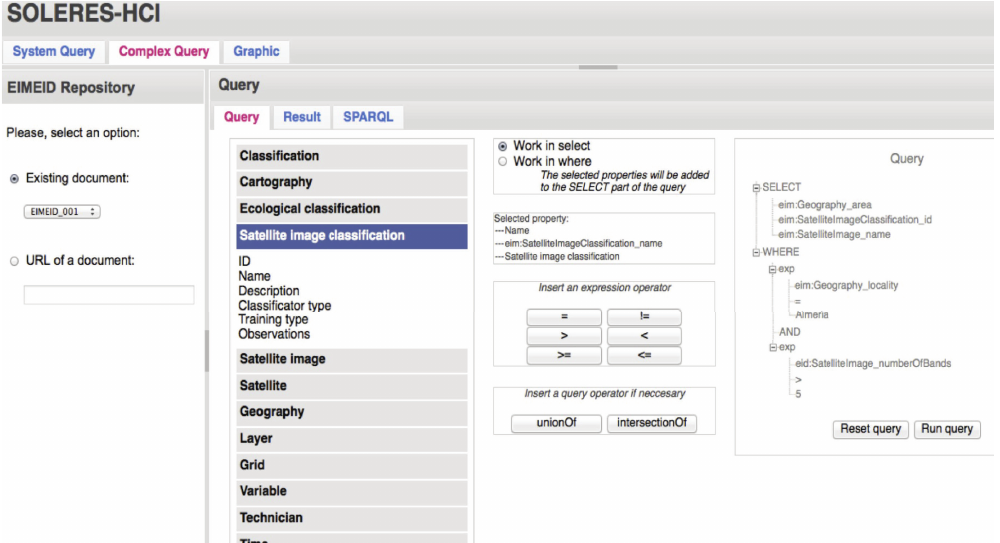
Figure 16: A portion of the Complex Query window in the test environment.